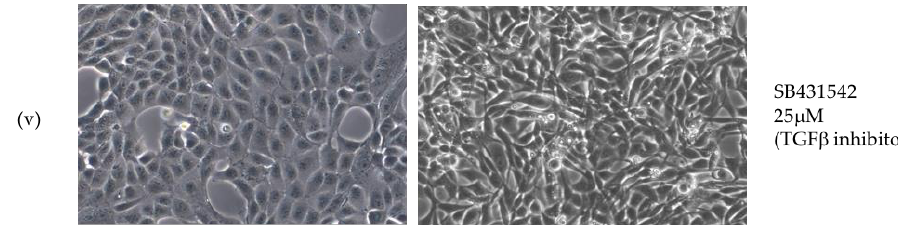
Figure 2. Specific chemical inhibitors “reverse” the transformed morphology of LMP1-expressing cells. Serum-starved MDCK control and wildtype LMP1 stably expressing cells were treated for 24 h with ( i ) the inert carrier solvent, dimethyl sulphoxide (DMSO), to a final concentration of 1:1000; or pharmacological inhibitors to ( ii ) PI3K (LY294002) to a final concentration of 25 μM; ( iii ) ERK-MAPK (UO126) to a final concentration of 60 μM; ( iv ) Src family kinases (SFKs; SU6656) to a final concentration of 10 μM; or ( v ) canonical Smad-dependent TGFβ (SB431542) to a final concentration of 25 μM. Representative phase contrast images were captured on a Zeiss digital microscope at 100× magnification.